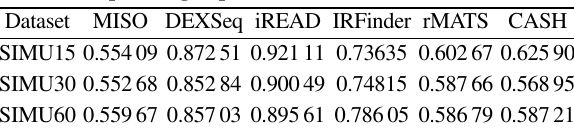
Fig. 2 Performance comparison for six methods in identifying IRs on SIMU30, (a) and (c) in terms of AUC, (b) and (d) in terms of AUPRC. Table 3 Comparison of AUC on the simulated datasets with different sequencing